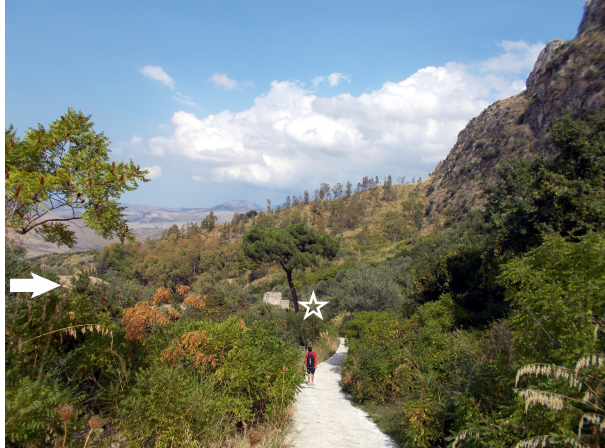
Figure 10. The present landscape surrounding the site of the ancient Sclafani spa. The arrow indicates the location of the rebuilt one- floor thermal establishment (1856–1857, the Masseria Bagni i.e. “thermal bath farm”). The star indicates today’s location of Sclafani thermal springs. For vantage point, see Fig.